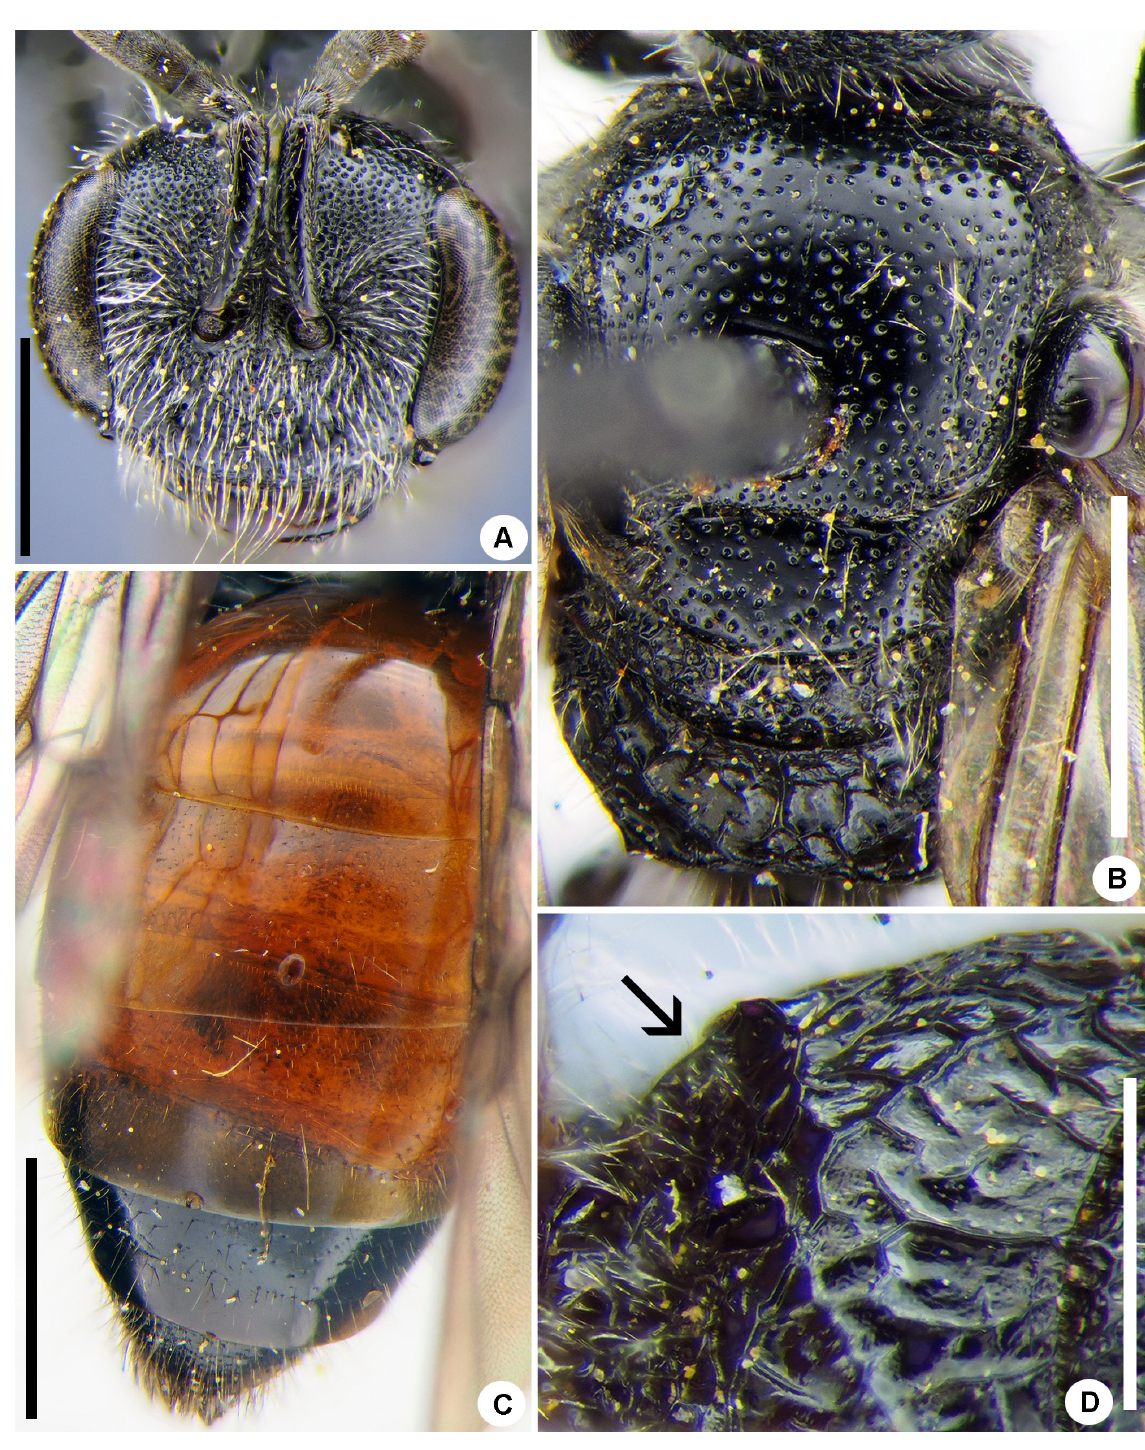
Fig. 7. Sphecodes bluethgeni sp. nov. Holotype, ♀ (PCMS/OLBL). A . Head in frontal view. B . Mesosoma in dorsal view. C . Metasoma in dorsal view. D . Propodeum in dorso-lateral view. Scale bars = 1